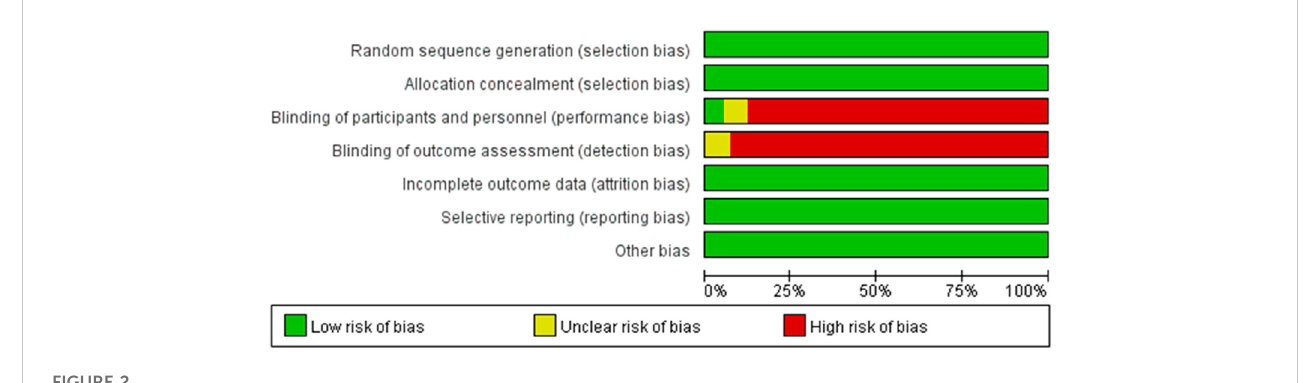
FIGURE 2 Judgment of bias risk.